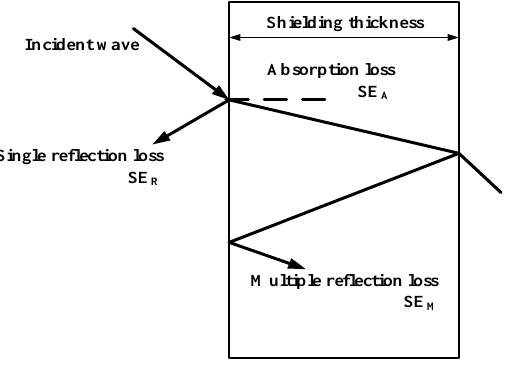
Figure 5. Electromagnetic wave behavior inside and outside of the shielding